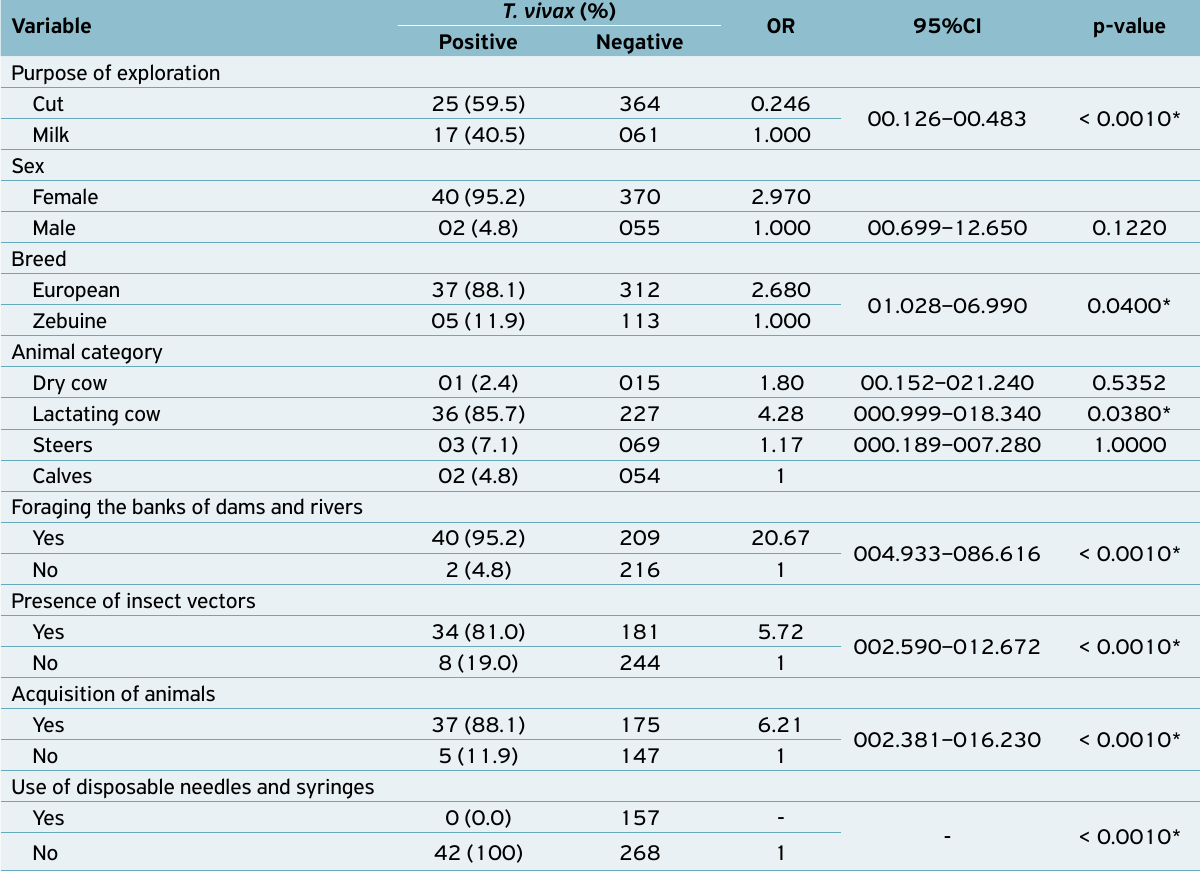
*Statistical significance (p < 0.05).